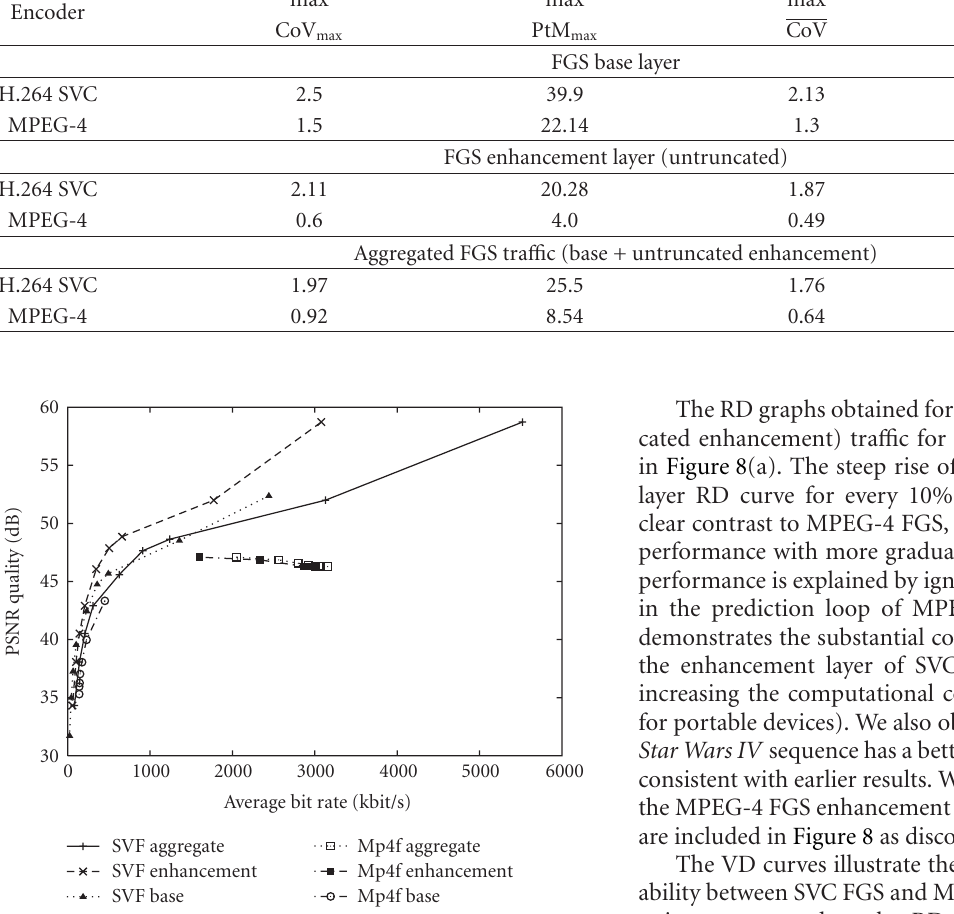
Figure 7: RD curves for SVC FGS and MPEG-4 FGS base and untruncated enhancement ( enh ) layers, and aggregated tra ffi c ( aggr ) of Silence of the Lambs sequence ( G16-B3